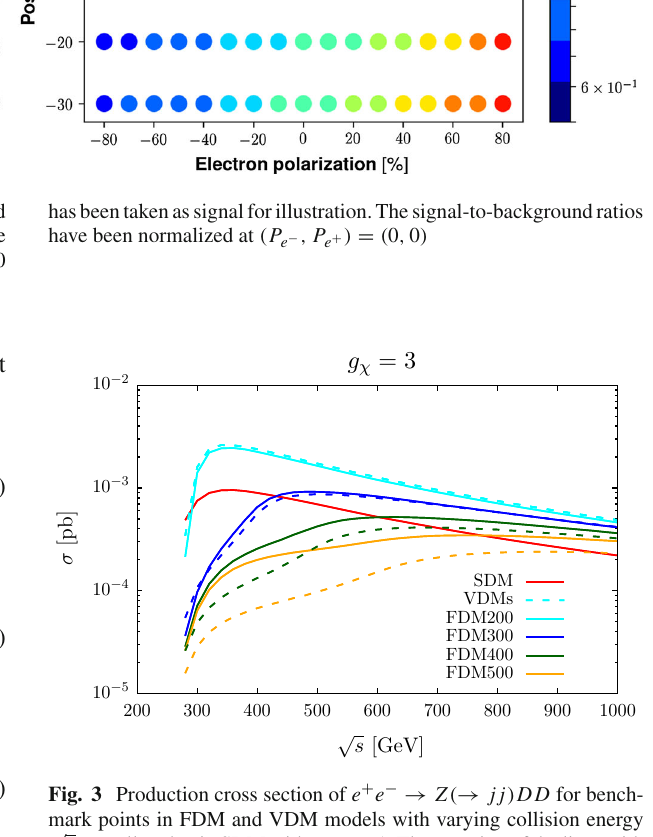
Fig. 3 Production cross section of e + e − → Z ( → jj ) DD for bench- mark points in FDM and VDM models with varying collision energy √ s as well as that in SDM with λ HS = 1. The meaning of the lines with different colors is indicated in the legend. The dashed lines correspond to the benchmark points in the VDM model which have the same H 2 mass as the points in the FDM model, which is shown by the solid line with the same